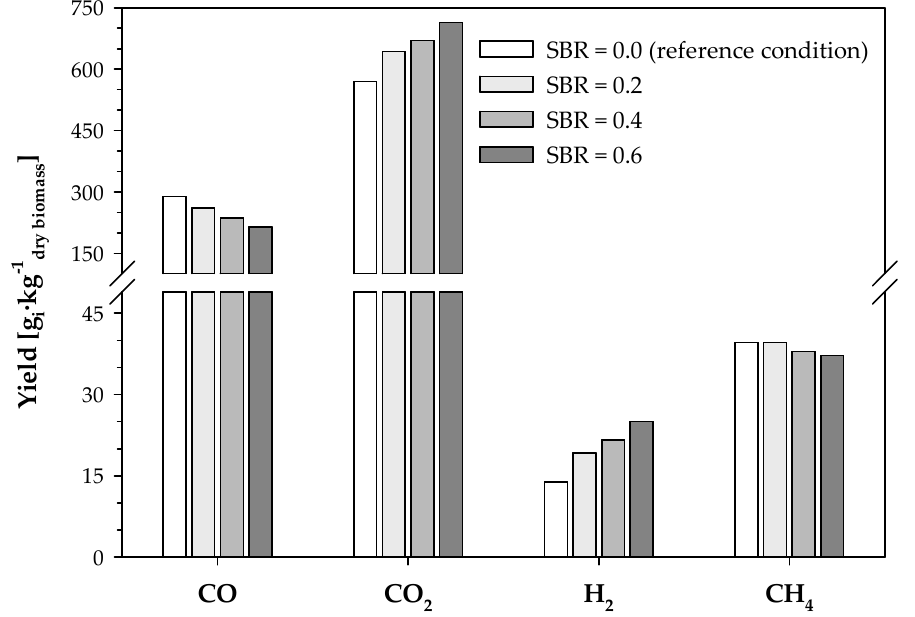
Figure 3. Effect of steam addition on the CO, CO 2 , H 2 , and CH 4 yield during air gasification of RFB from eucalyptus ( φ = 20 %vol. O ₂ , dry GA —Tables 3 and 4).